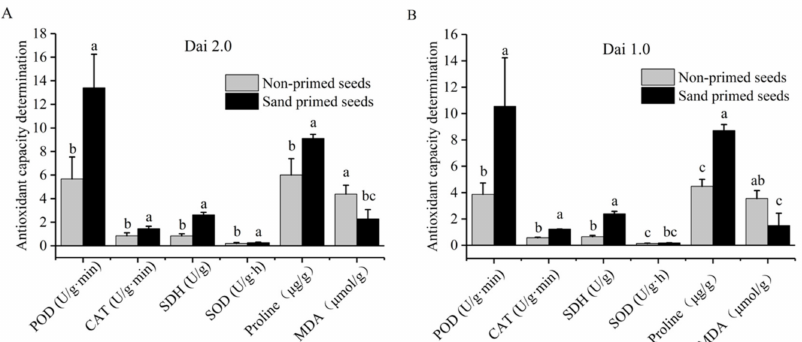
Figure 1. Effects of sand priming on enzymatic activities and the content of proline and MDA of Pinus massoniana . ( A ) The result of Masson pine variety “Dai 2.0”. ( B ) The result of Masson pine variety “Dai 1.0”. The same lowercase letters are not significantly different at p < 0.05, according to Duncan’s multiple range test. MDA: malondialdehyde; CAT: catalase; SOD: superoxide dismutase; POD: peroxidase, SDH: succinate dehydrogenase.